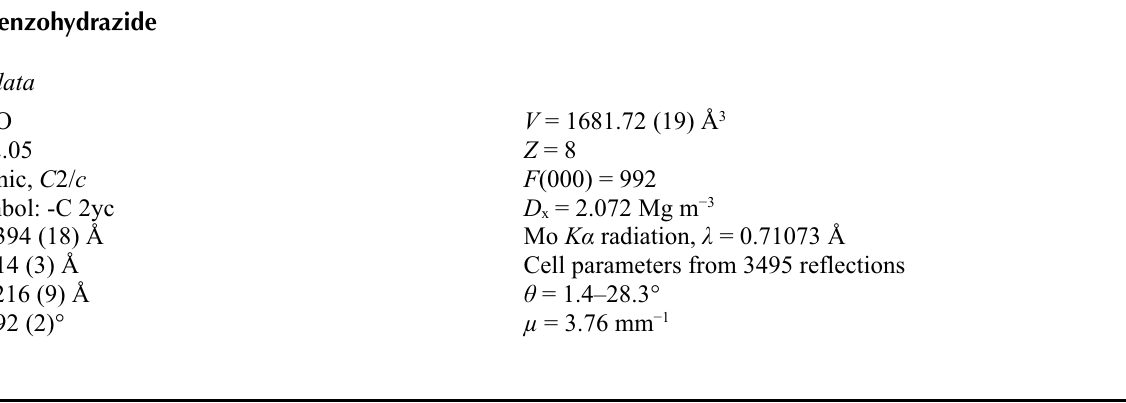
The hydrogen bonding patterns of (I) represented by dashed lines in the unit cell; H-atoms not involved in H-bonds have been